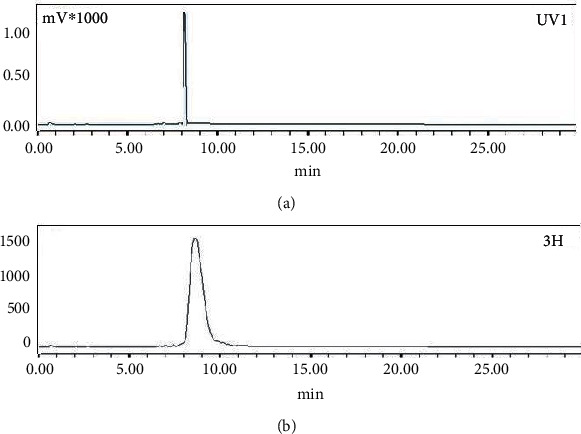
Typical HPLC profiles of (a) inactive Lu-acridine and (b) 177Lu-acridine.